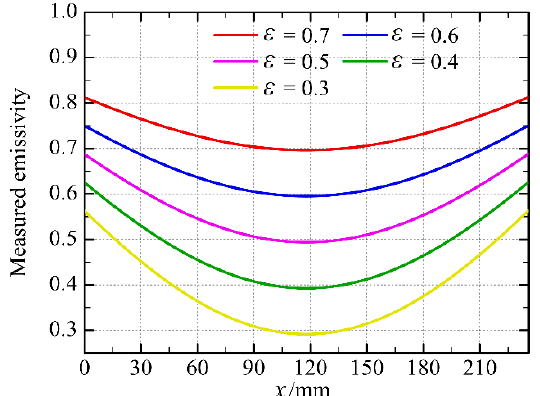
Figure 10. Emissivity measurements obtained directly by the irradiation reflection method.